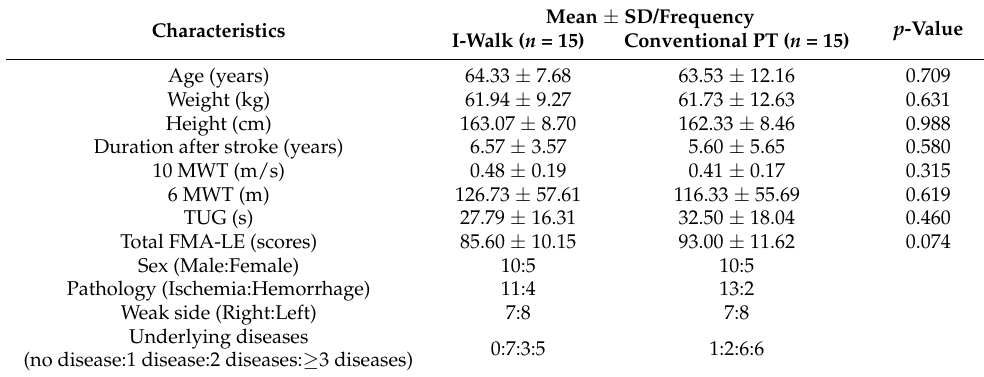
Table 1. General characteristics in conventional PT and I-Walk gait training in chronic